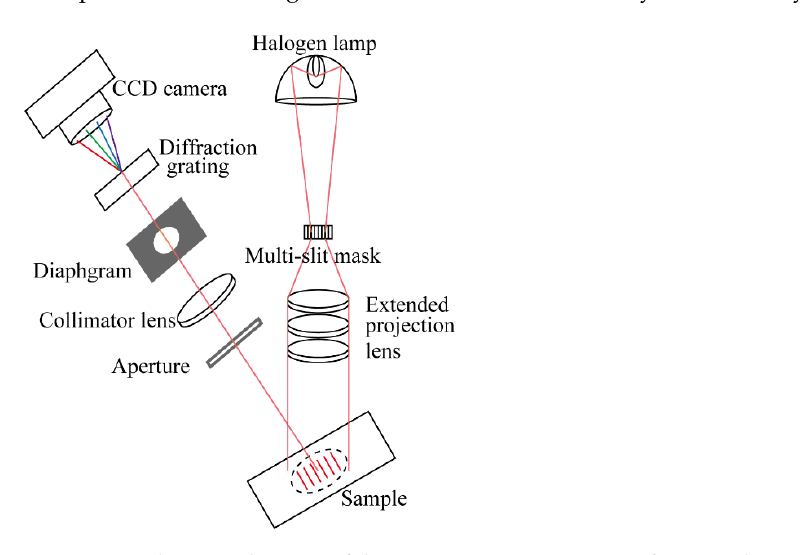
Figure 2. A schematic diagram of the measurement instrument for optical properties.